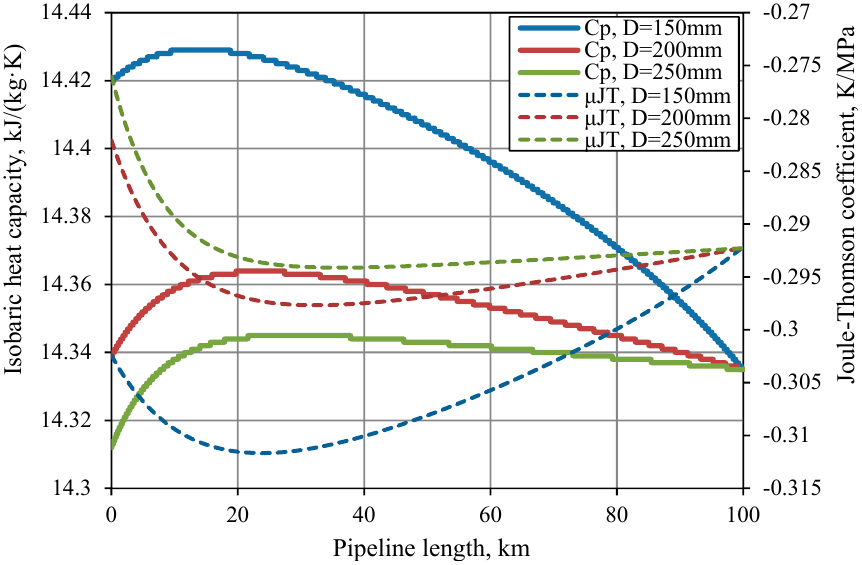
Figure 12. Isobaric heat capacity ( Cp ) (continuous lines) and Joule–Thomson coefficient ( µ JT ) (dashed lines) changes for hydrogen mass flow rate 1.0 kg/s (40,000 Nm 3 /h).